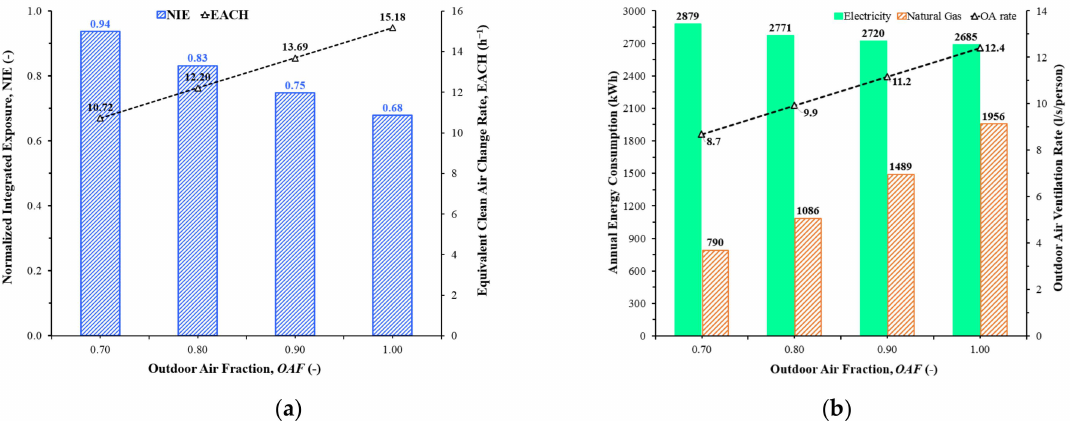
Figure 6. Effect of mechanical ventilation using outdoor air: ( a ) on the NIE of CAHS for 3 h per day of continuous exposure; ( b ) associated electricity and natural gas consumption.